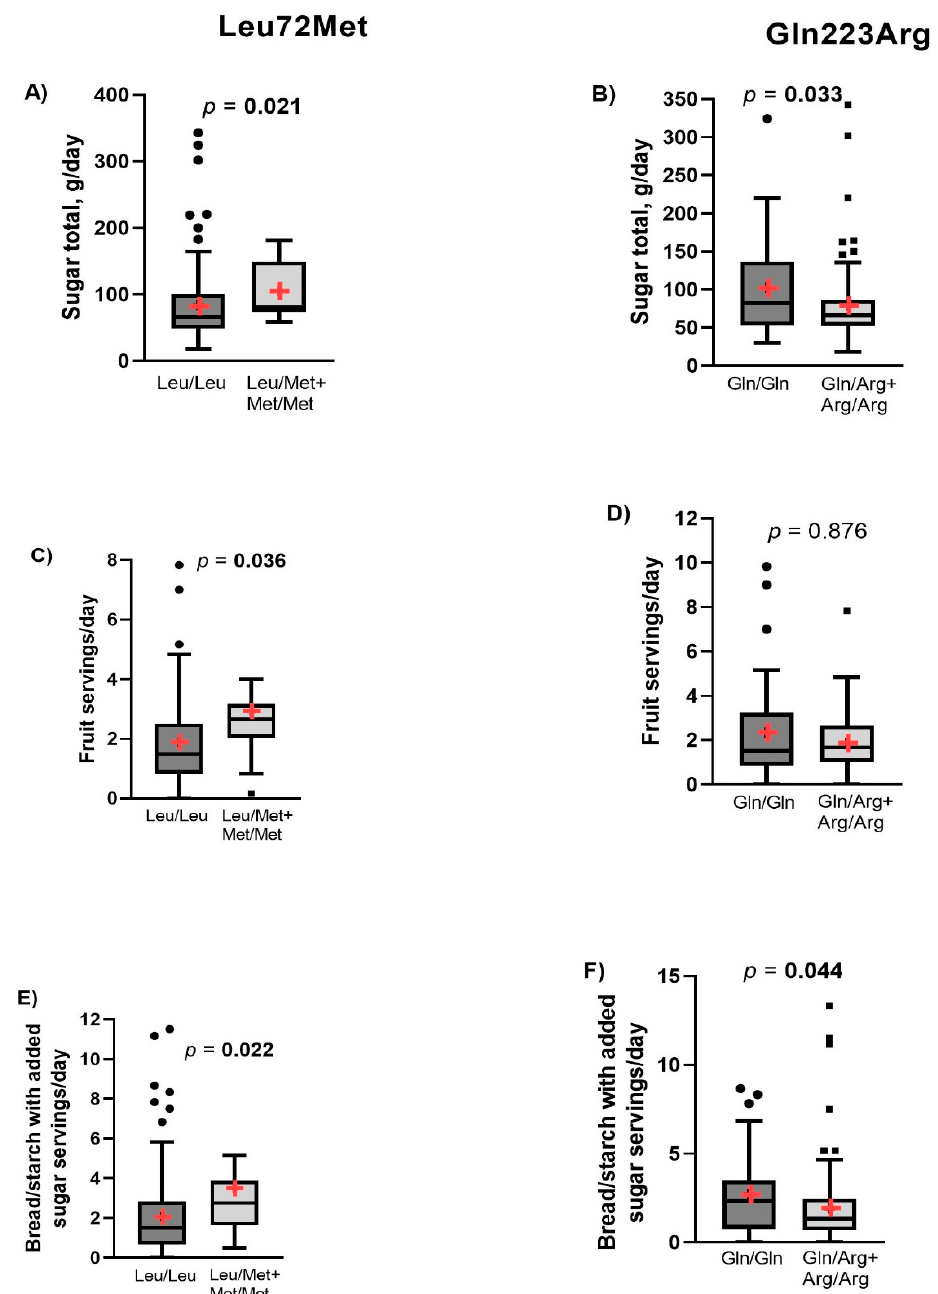
Figure 3. Differences in carbohydrate sources according to Leu72Met of GHRL and Gln223Arg of LEPR. Graphs ( A , C , E ) show dietary intake of total sugar, fruit servings, and bread/starch with added sugar servings between Leu72Met genotypes, respectively. Graphs ( B , D , E ) show the same dietary intake variables according to the Gln223Arg genotypes. The data are represented as median and IQR (percentile 25–75). The + symbol represents the mean. Differences between genotypes were calculated with the Mann–Whitney U test. A p -value < 0.05 was considered statistically significant. Bold numbers highlight statistical significance.